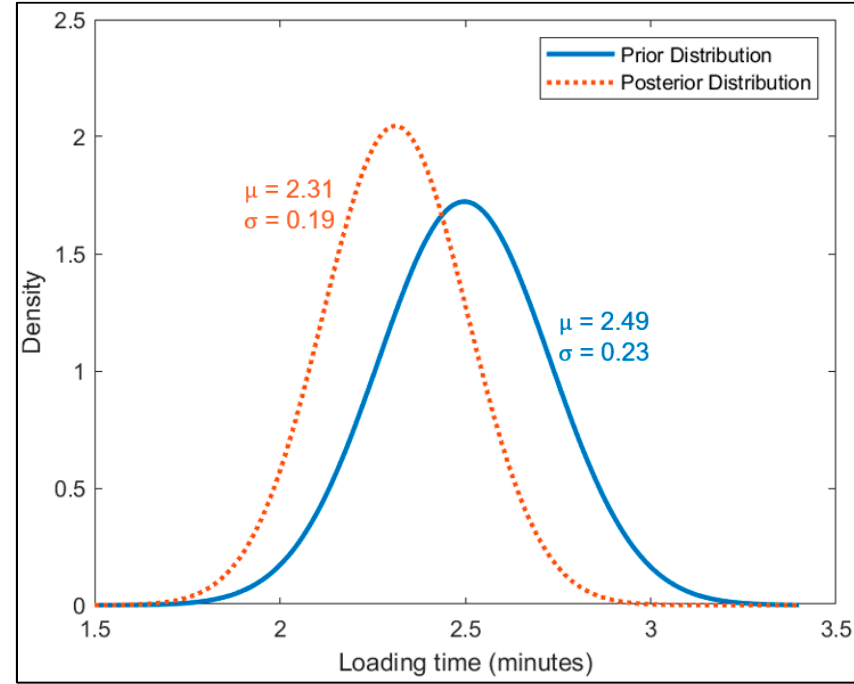
Figure 14. Prior and posterior normal distribution of the loading time after day 2.